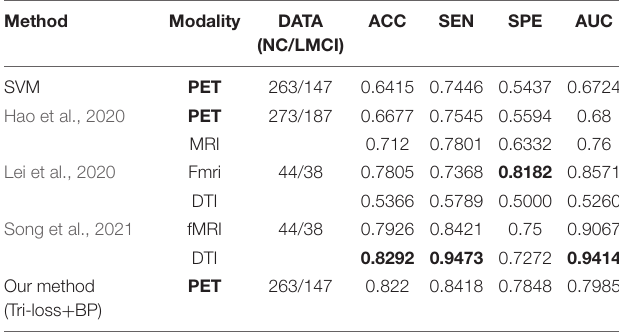
The bold values represent the highest number.